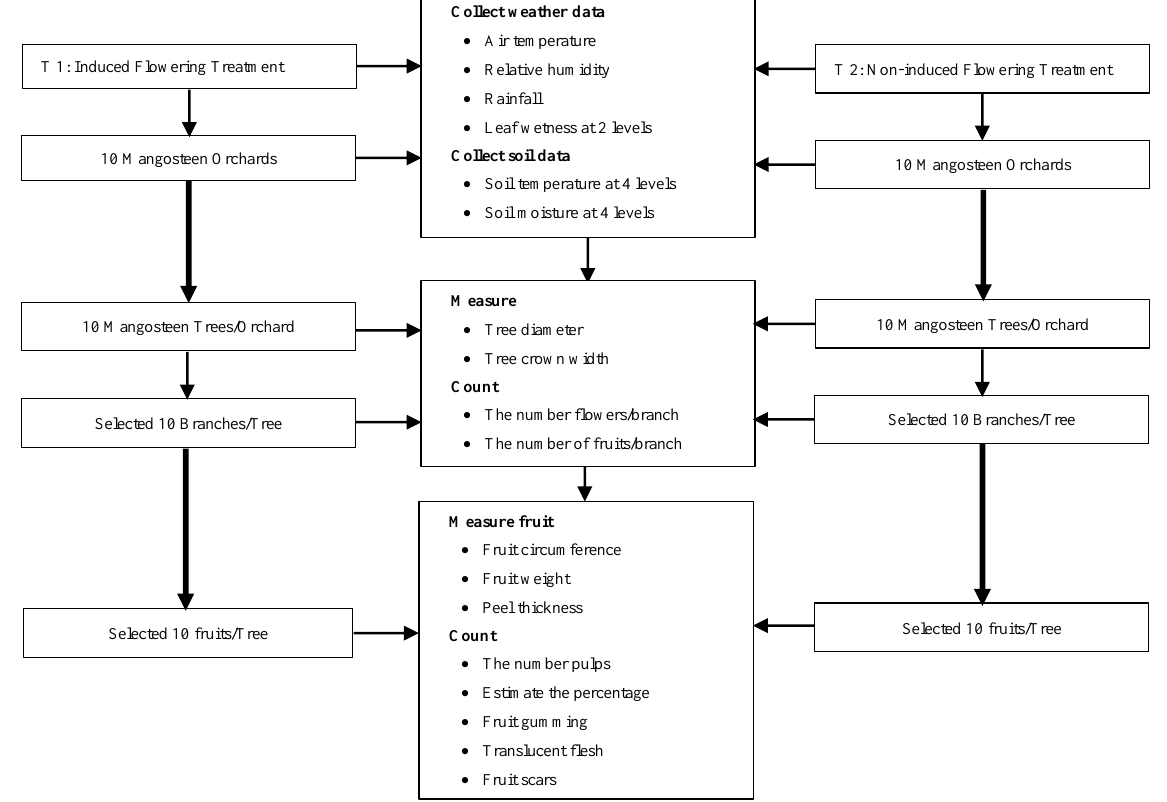
Figure 1. Research methodology on climatic factors and mangosteen fruit quality between on and off-season